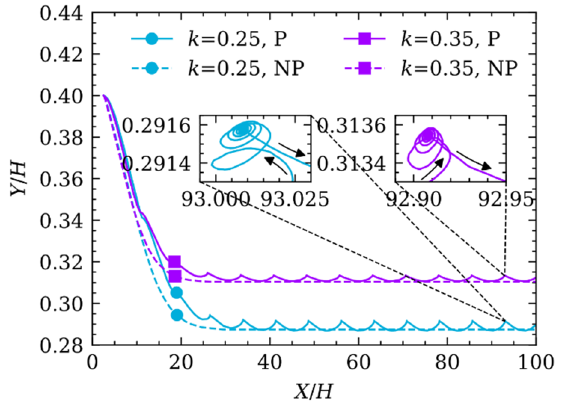
Figure 7. The particle center trajectory for k = 0.25 (two sky-blue curves with circle marker), k = 0.35 (two purple curves with square marker) at Re = 50. Solid curve represents the case driven by pulsatile velocity, which is abbreviated as P, while NP is the acronym for non-pulsatile flow donated by dash curve. Re at k = 0.25, and ( b , d ) donates different k at Re = 50. Moreover, ( c , d ) is the